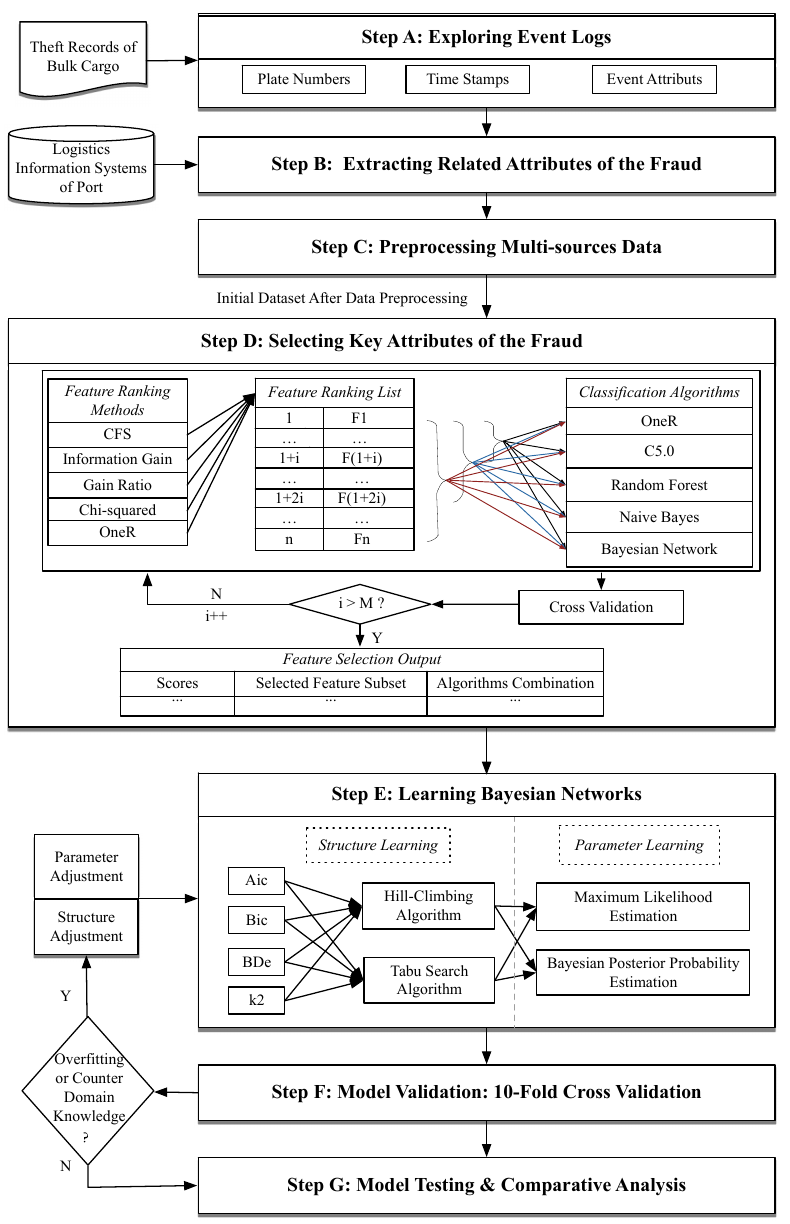
Figure 1. The methodology of the proposed method for constructing the predictive model of fraud detection on bulk cargo theft in port. (For a detailed explanation, see previously in Section 3.2.).